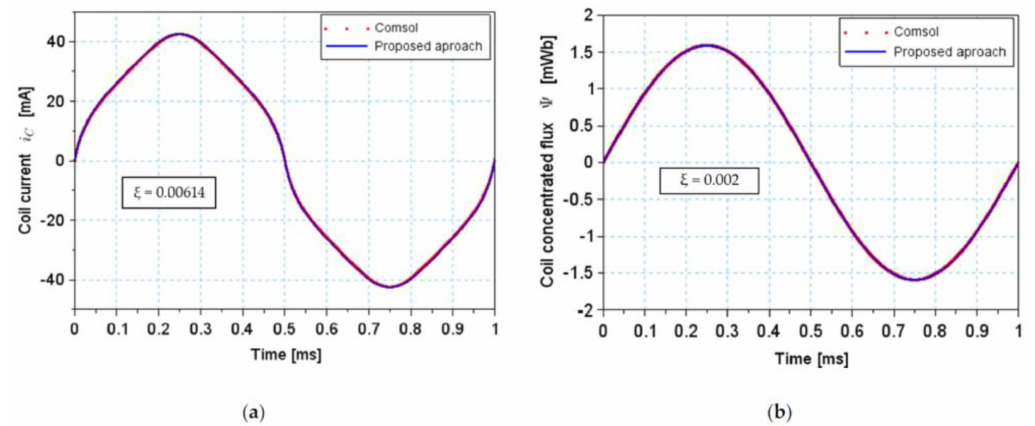
Figure 4. Presented in [5] as Figure 19 ( a ) Inductor current ic waveforms for the case of a sinusoidal voltage source and frequency of 1 kHz. ( b ) Flux linkage Ψ waveform for the case with a sinusoidal voltage source and frequency of 1